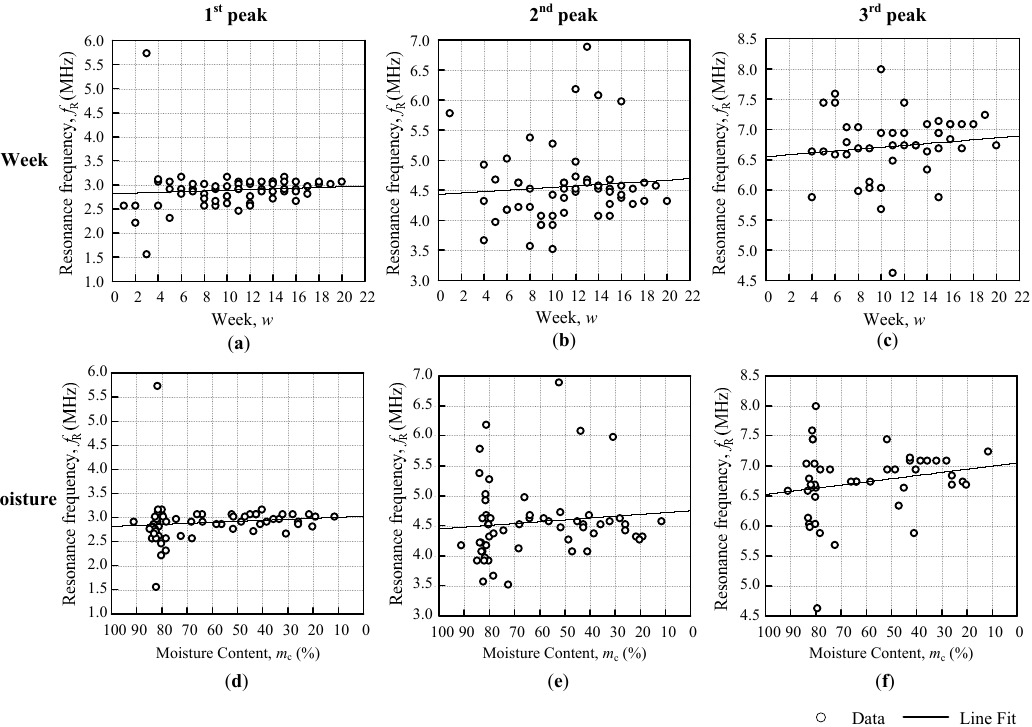
Figure 10. Triple I first, second, and third peak resonance frequency against the weeks ( a – c ) and moisture ( d – f ). Sensors 2018 , 18 , x FOR PEER REVIEW